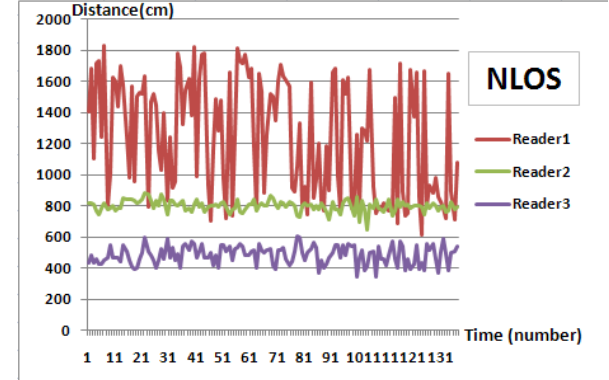
Fig. 8. Tracking performance under a NLOS